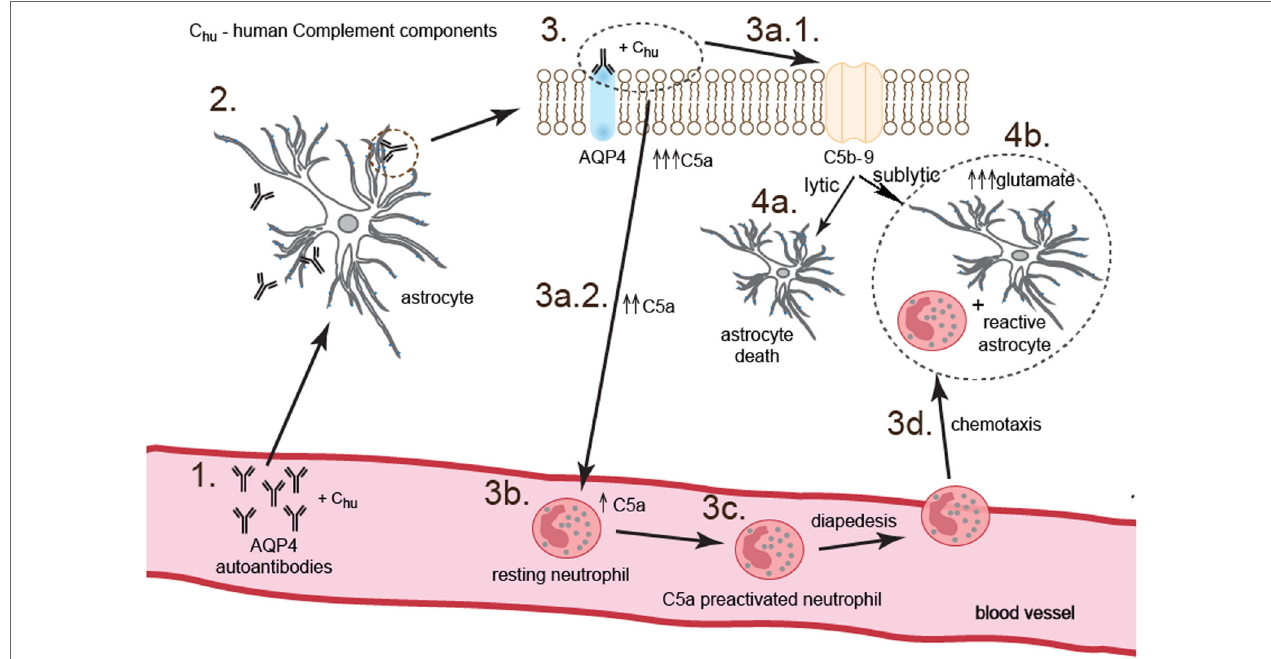
FigUre 6 | Anti-aquaporin-4 (AQP4) Ab binding astrocytes initiate two parallel complementary reactions. The first one is dependent on the complement cytotoxicity via C5b-9 complex formation (pathway 3.–3a.1.–4a.), and the second one on the sublytic effect of C5b-9 and dysregulation of astrocyte glutamate pump into extracellular space by C5a-preactivated neutrophils (pathway 3.–3a.2.–3b.–3c.–3d.–4b.). As a consequence, astrocytes are partially destroyed; however, a major population of astrocytes polarizes into proinflammatory cells which produce cytokines and chemokines and are characterized by pathological glutamate removal from extracellular